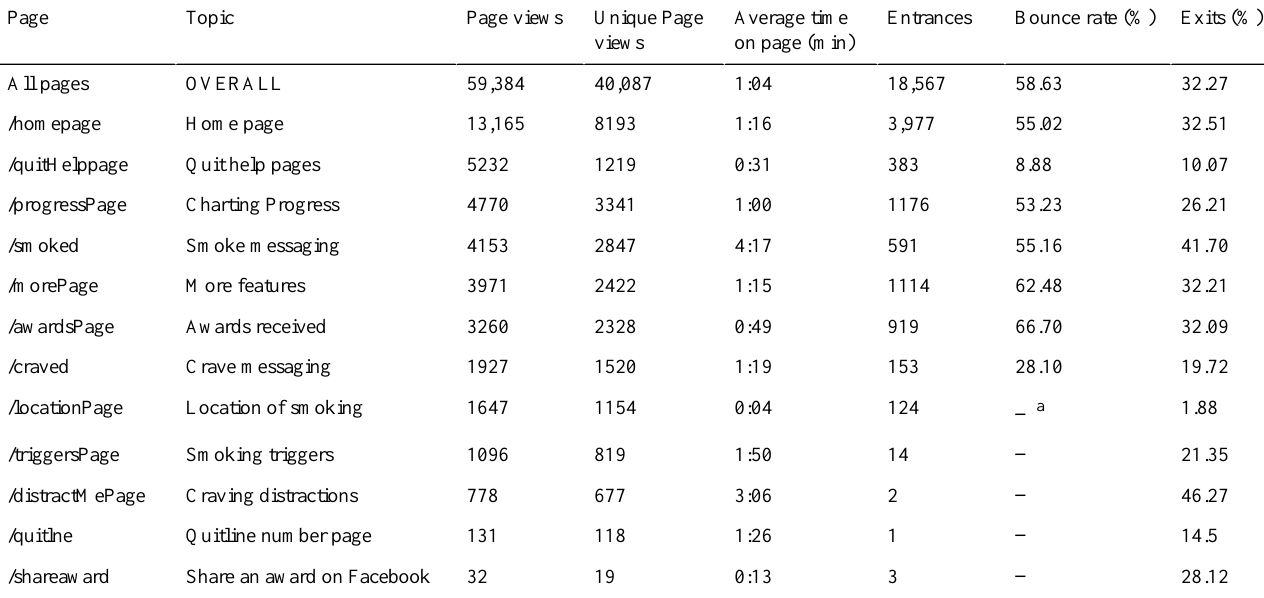
Table 3. User behavior associated with Crush the Crave (CTC) app pages—July 2013 to June 2014.